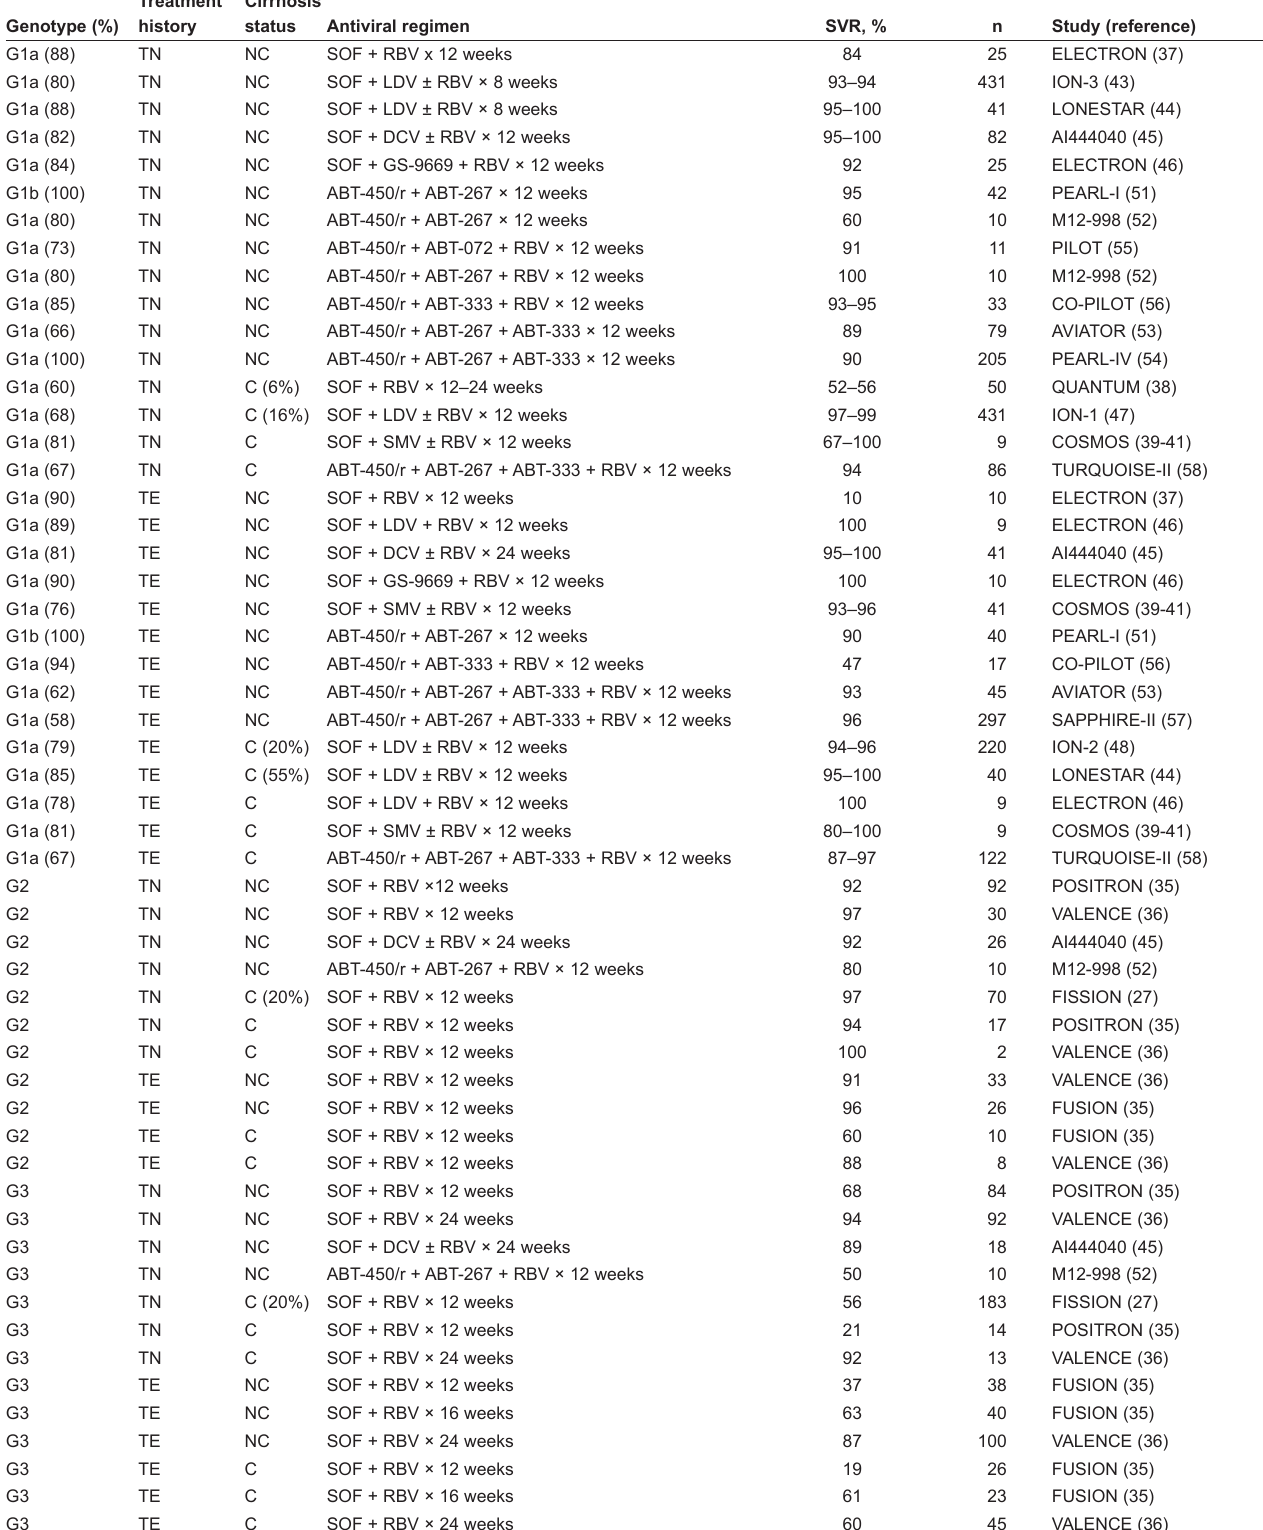
TAble 4 Sustained virological response (SVR) of sofosbuvir (SOF)- and AbT-450/r-based